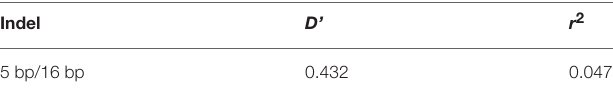
TABLE 3 | Estimated values of linkage equilibrium analysis for two indels in KDM6A gene in studied populations. Indel D’ r 2 5 bp/16 bp